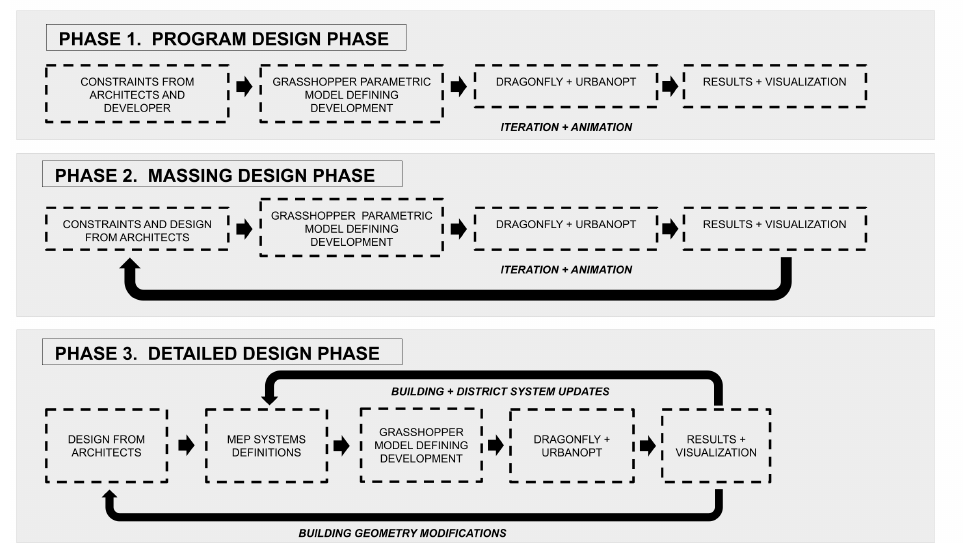
Figure 9. Dragonfly/URBANopt integration in different design